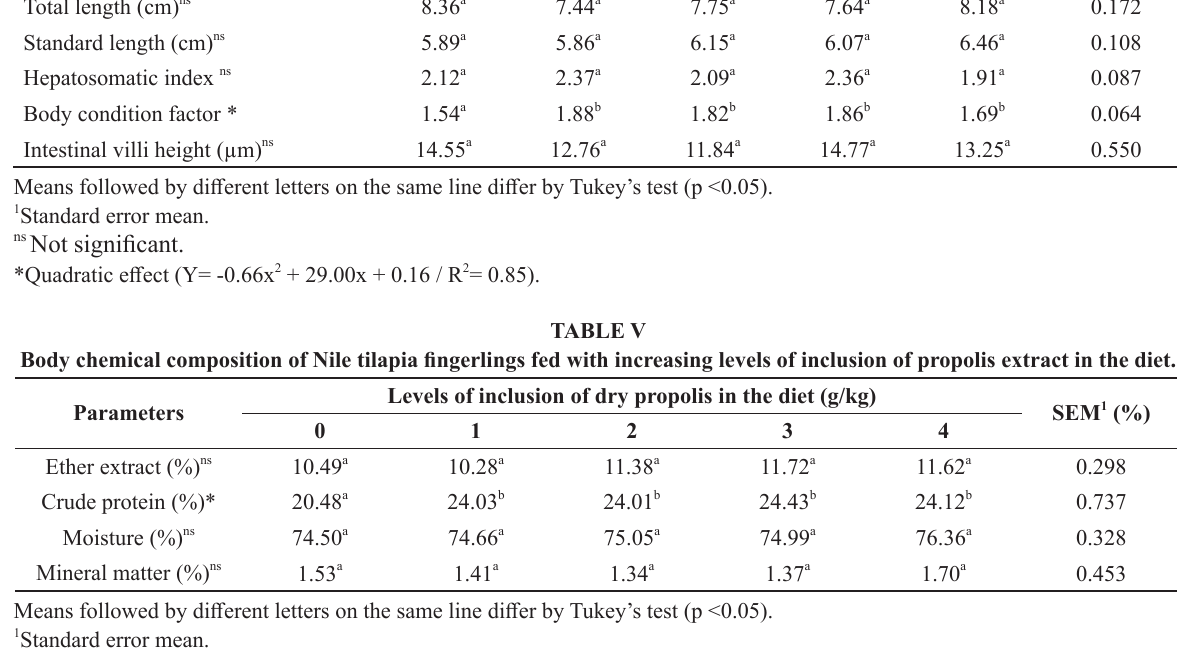
Mineral matter (%) ns Means followed by different letters on the same line differ by Tukey’s test (p <0.05). 1 Standard error mean. ns Not